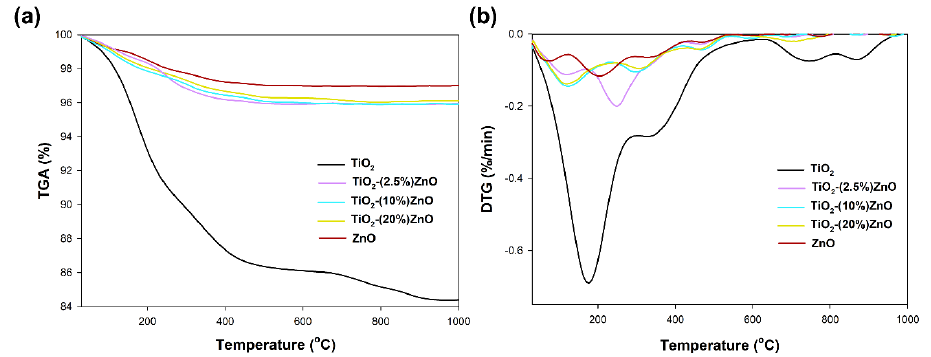
Figure 11. TGA ( a ) and DTG ( b ) curves of TiO 2 -ZnO systems and reference samples. For the reference titanium dioxide sample, a total mass loss of 15% was